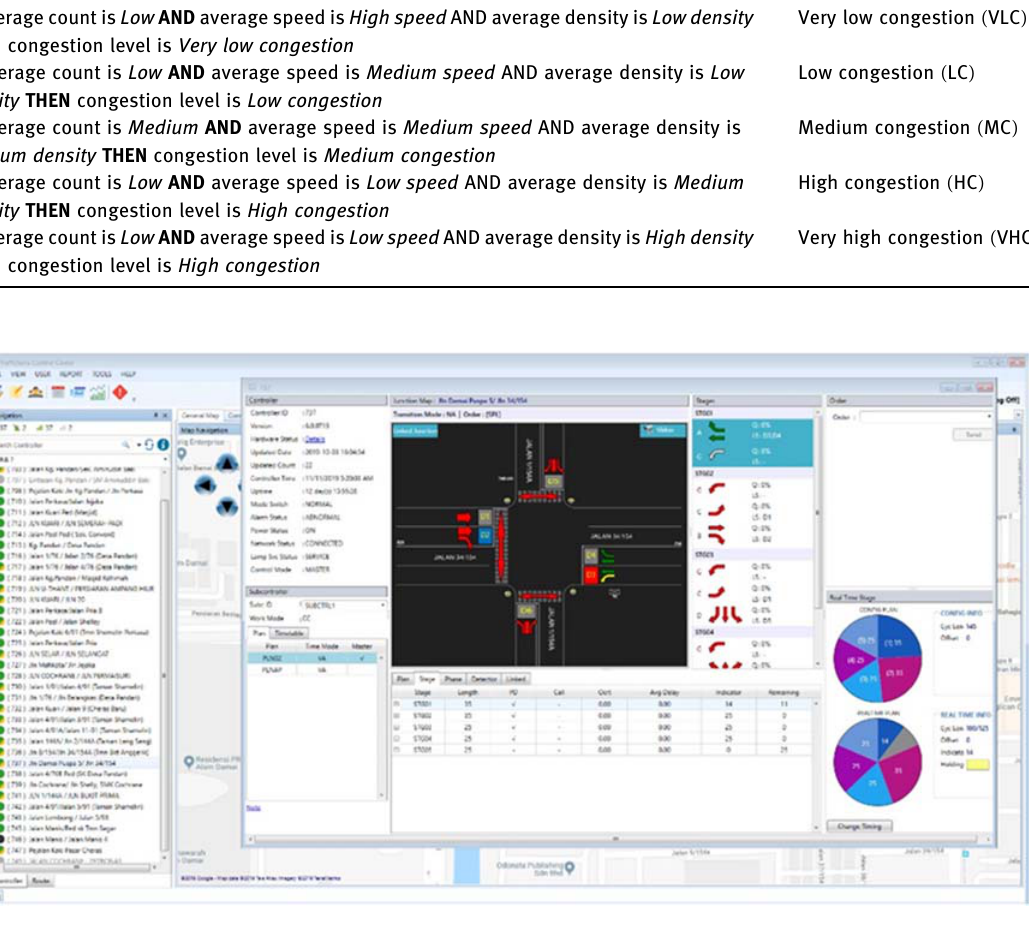
Figure 7: The Sena tra ffi c control center ( Tra ffi csens )